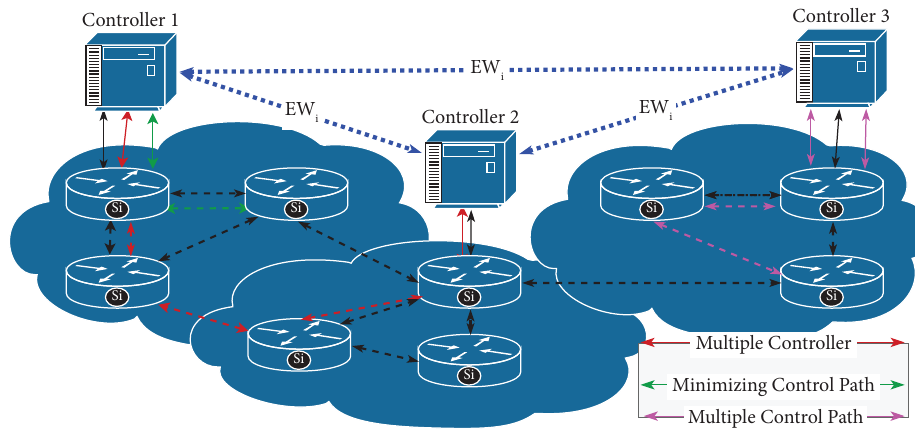
Figure 9: Resilience CPP design